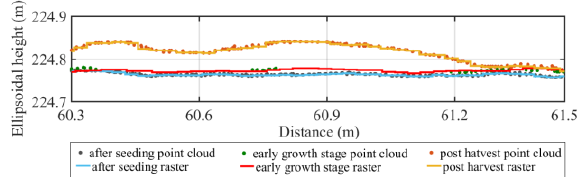
Figure 8: Example of a cross section of the reference surface rasterization. The points are point cloud data derived from after seeding (grey), early growth stage (green) and post-harvest (orange). The lines represent derived raster from each point cloud data using median value per cell with 3 cm size.